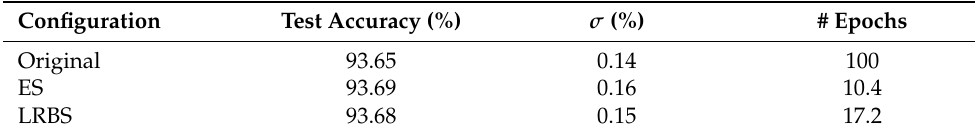
Table 9. Results on MedMNIST2D OCTMNIST dataset in maximum 100